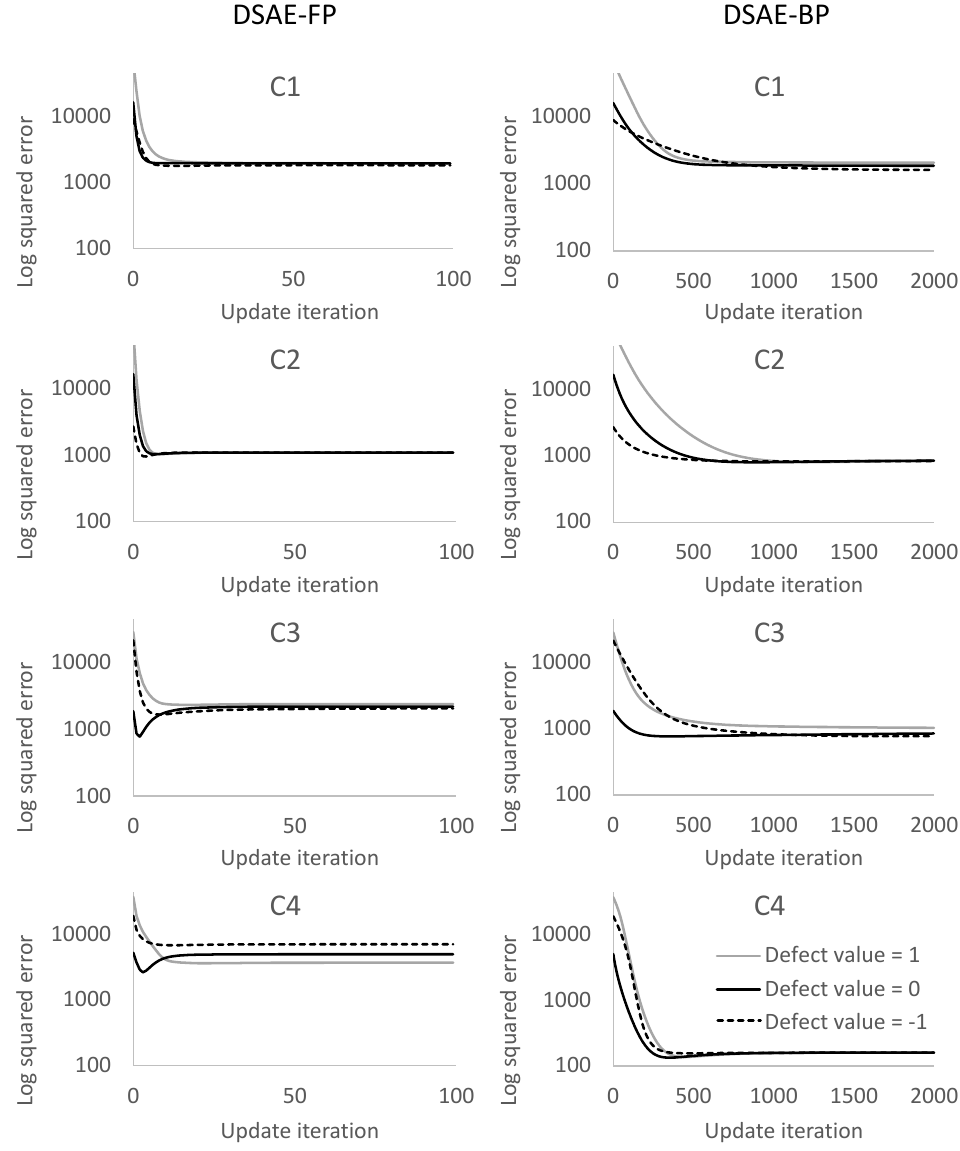
Figure 10. Square error between the repaired sensor time-series data and non-defective sensor time-series data for C1 to C4 at each update iteration. The plots in the columns on the left and right represent the results obtained by using DSAE-FP and DSAE-BP,